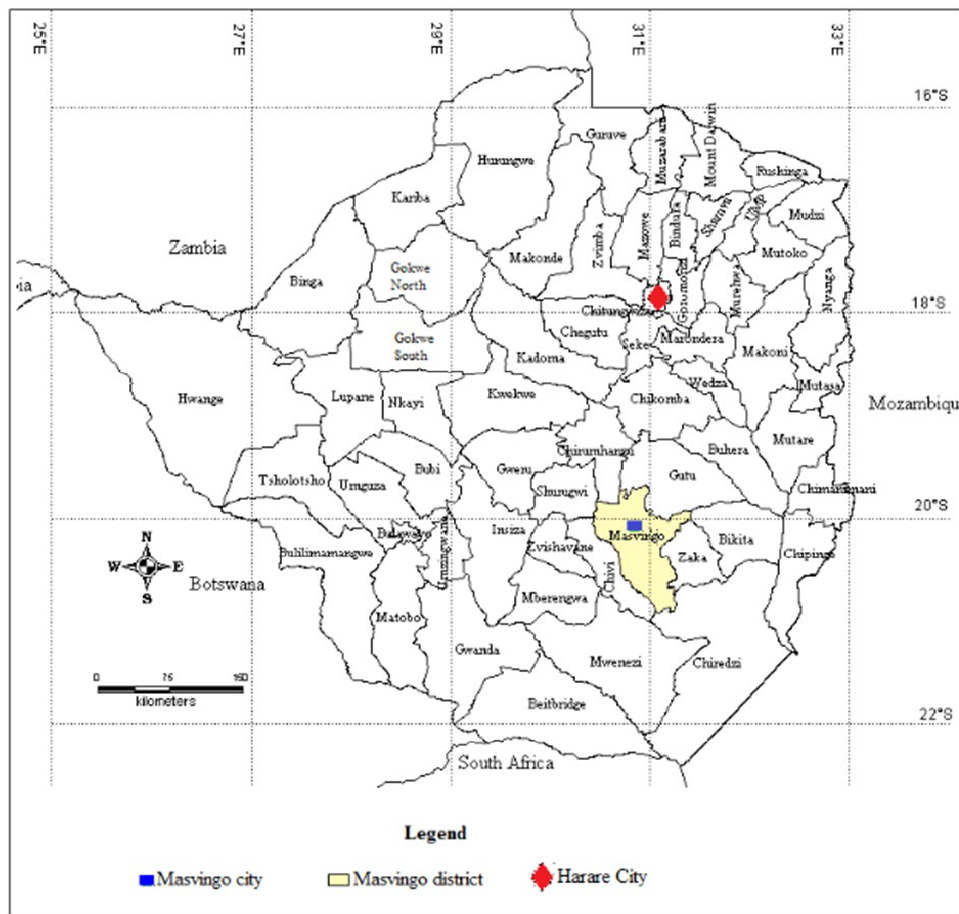
Figure 1. Map of Zimbabwe showing the City of Masvingo [31].